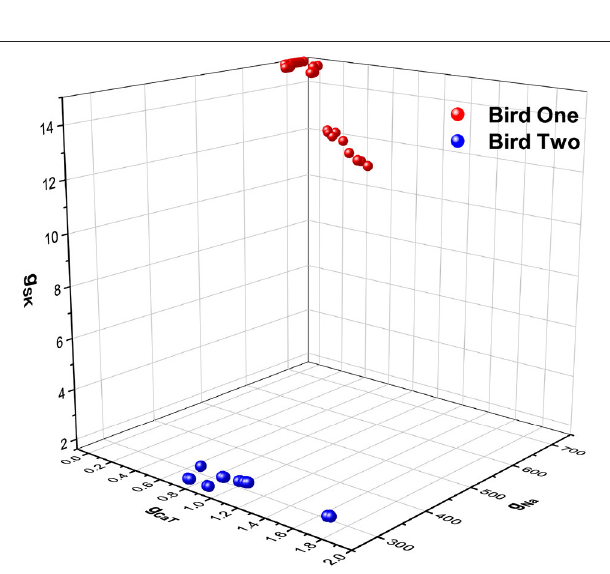
FIGURE 7 | A three dimensional plot of three of the maximal conductances estimated from HVC X cells using the stimulating current shown in Figure 6A . Membrane voltage responses from five neurons from one bird were recorded many times, and membrane voltage responses from four neurons from a second bird were recorded many times. One set of maximal conductances g Na , g CaT , g SK are shown. The estimates from Bird 1 are in red-like colors, { } and the estimates from Bird 2 are in blue-like colors. This is just one out of a large number of examples discussed in detail in Daou and Margoliash (in